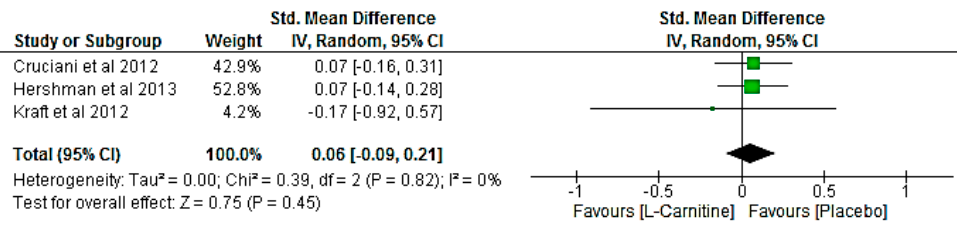
Figure 2. Forest plot of the effect of Carnitine dietary supplement on Cancer-related fatigue. CI=confidence interval; IV=inverse variance.